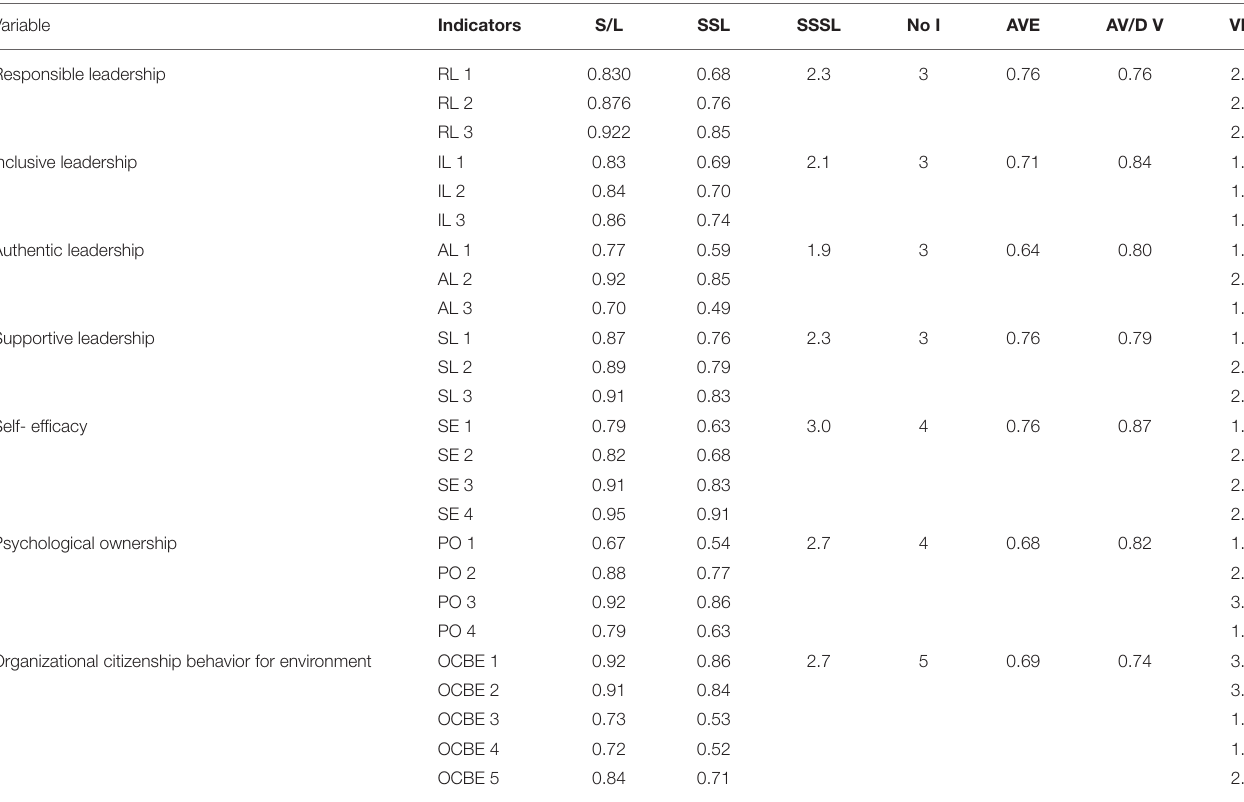
TABLE 3 | Factor loadings and convergent validity results.